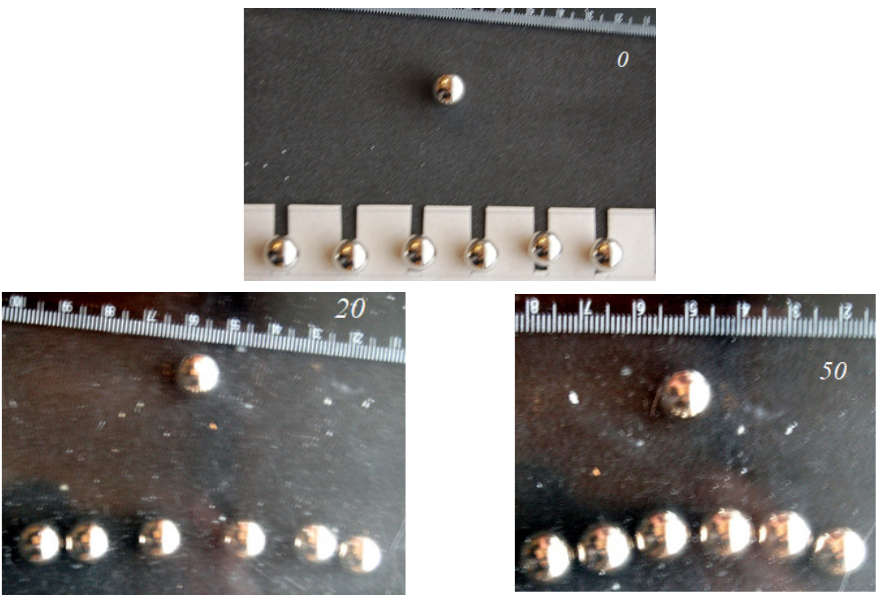
Figure 3. Movement along the line of balls (the initial distance between the centers in the line was 15 mm). The number of cycles is reported in the upper right corner.